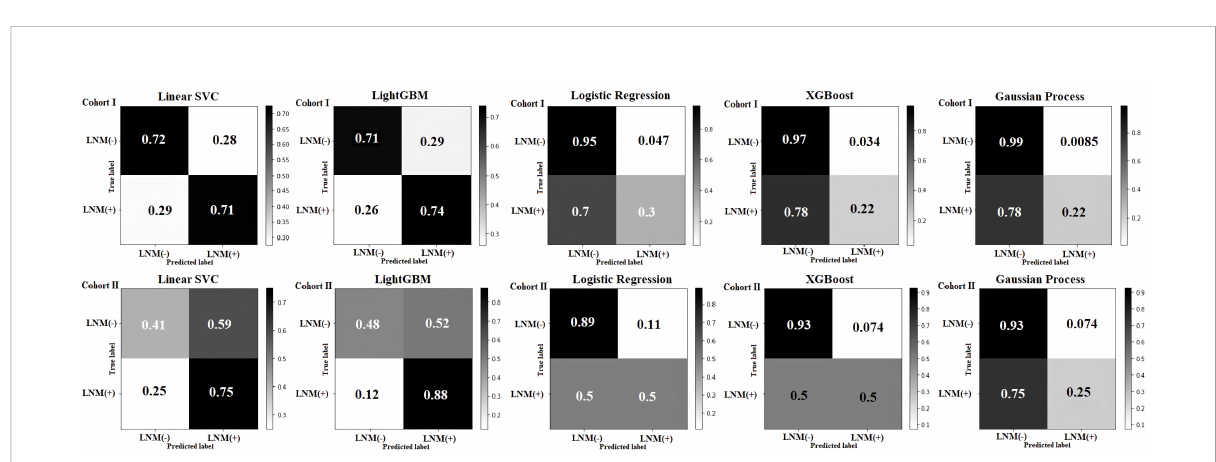
FIGURE 4 Confusion matrix of the cohort I and the cohort II in fi ve machine learning models. In each subplot, the speci fi city, false positive rate (FPR), false negative rate (FNR), and sensibility were shown from top left to bottom right,